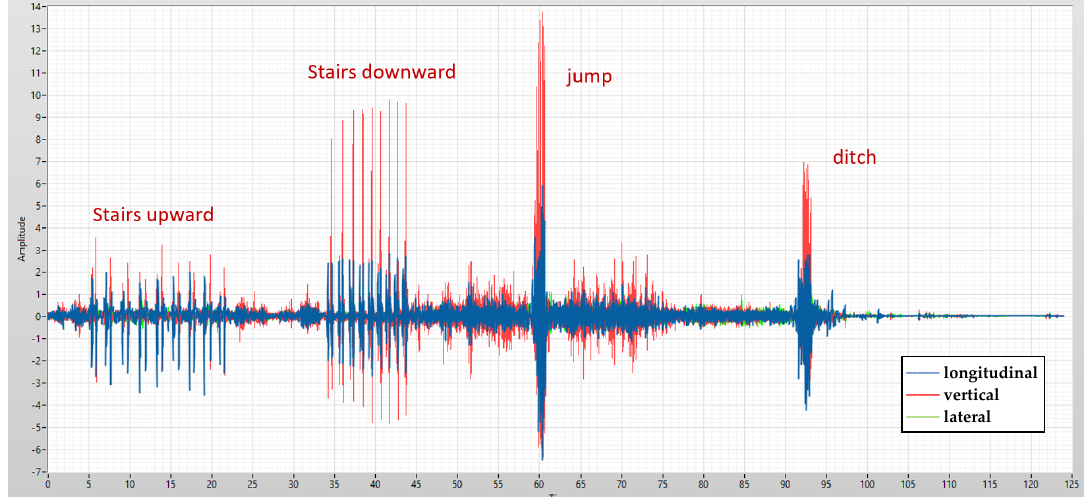
Figure 3. Measured signal before filtering. Table 1. Maximal acceleration in each direction and obstacle type.